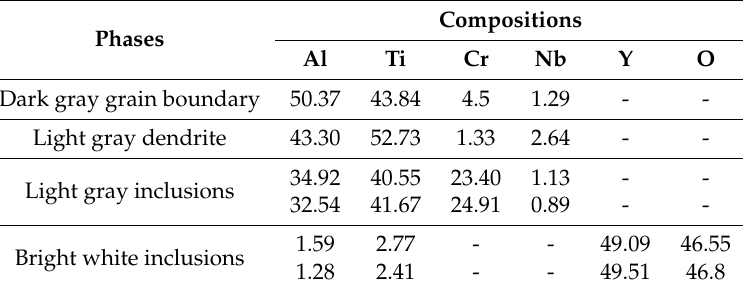
Figure 6. The XRD spectra of the interior of metal particles. Table 3. The internal components of the metal particles.